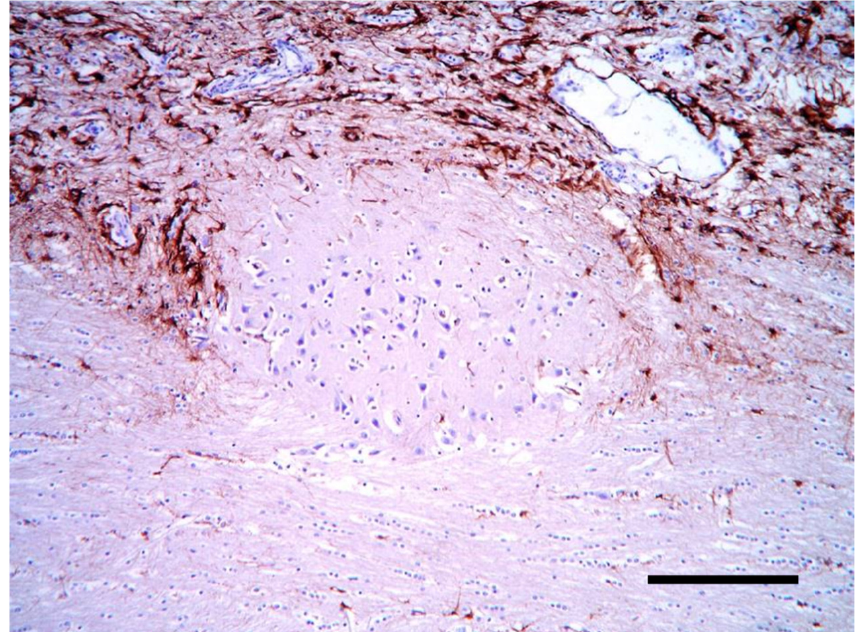
Figure 9. Cerebral cortex of the cat. A heterotopic cluster of neural cells is surrounded by astrocytes and prominent vascular structures (GFAP IHC, bar = 200 μ m).